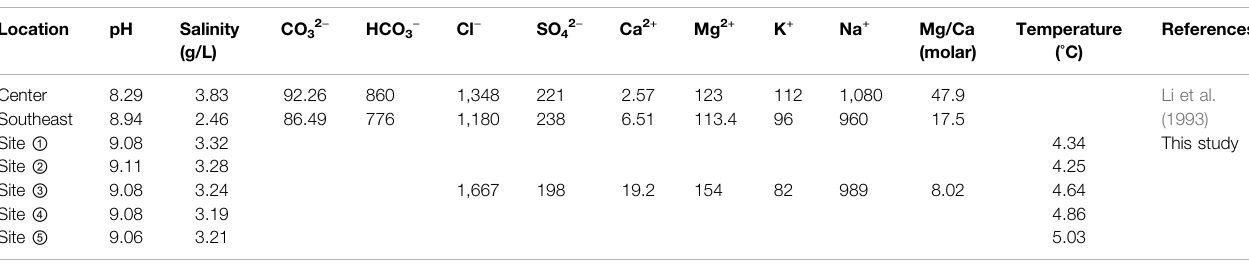
TABLE 1 | Salinity, pH, ion concentrations (ppm), and temperature ( ° C) of Guozha Co water